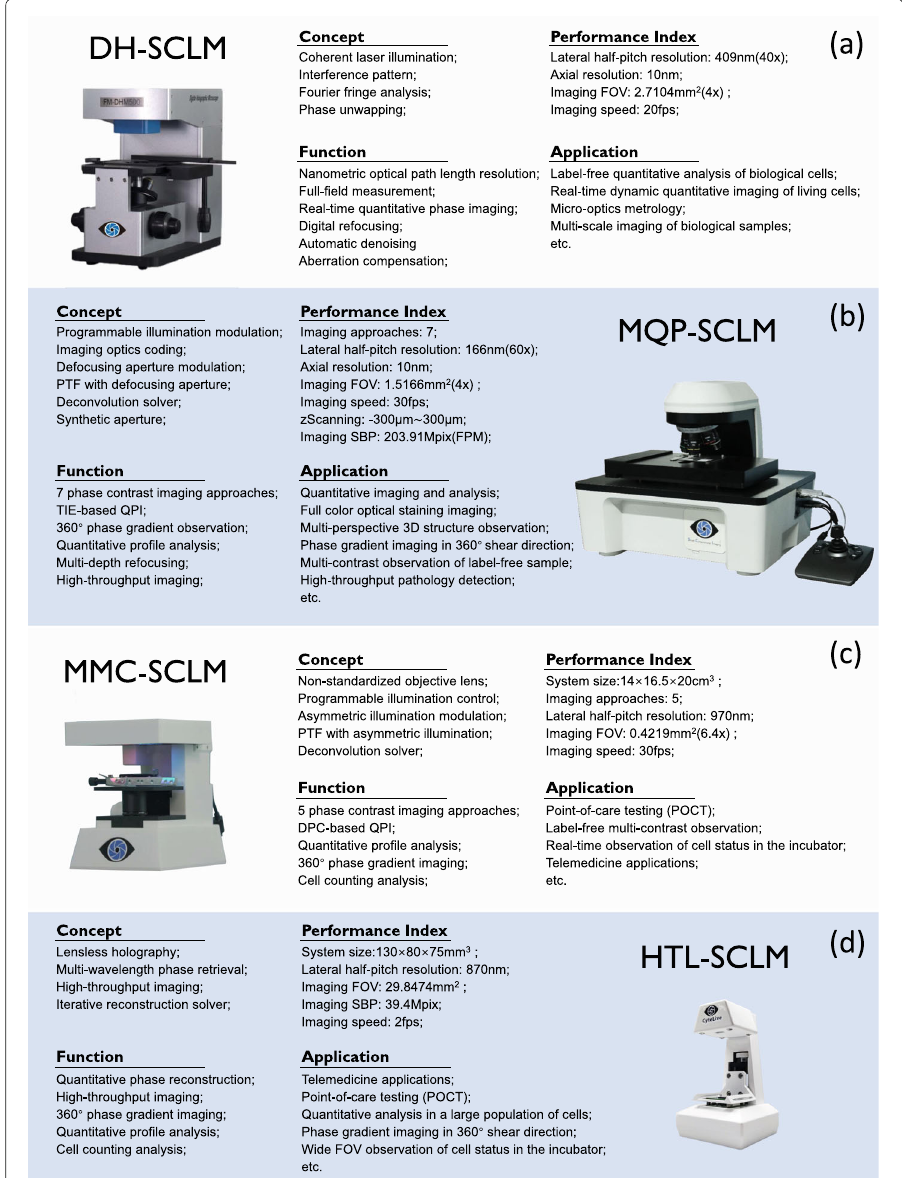
Fig. 4 Design concepts, imaging functions, performance indexes, and intended biomedical applications of four SCLMs